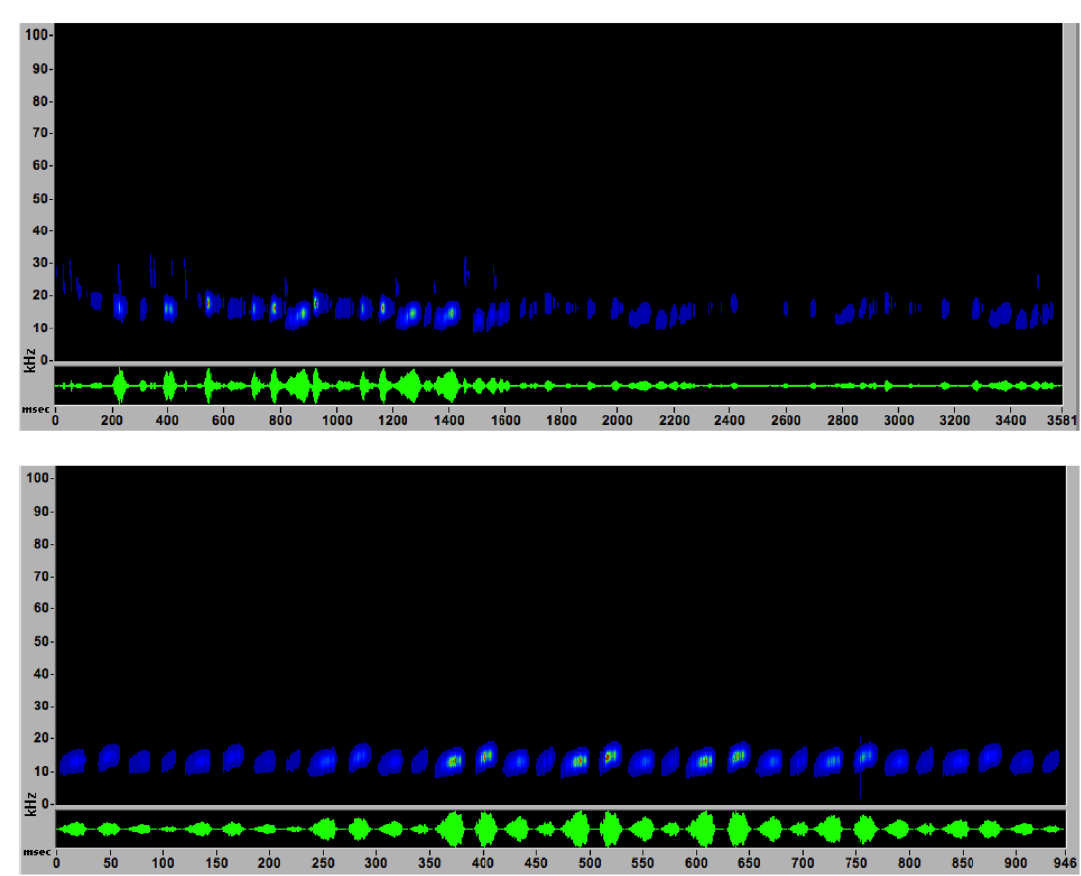
Figure 3. Hoary bat ( Lasiurus cinereus ) social playback files Laso1 ( a ) and Laso2 ( b ), constructed from wild recorded social calls recorded in New Mexico, USA, used in broadcast trials. Laso1 contained an assortment of social call files strung together, while Laso2 contained a sequence of 4 calls from one recording, looped to create a longer sequence. Time in milliseconds is on the x axis, and frequency in KHz on the Y axis, displayed in